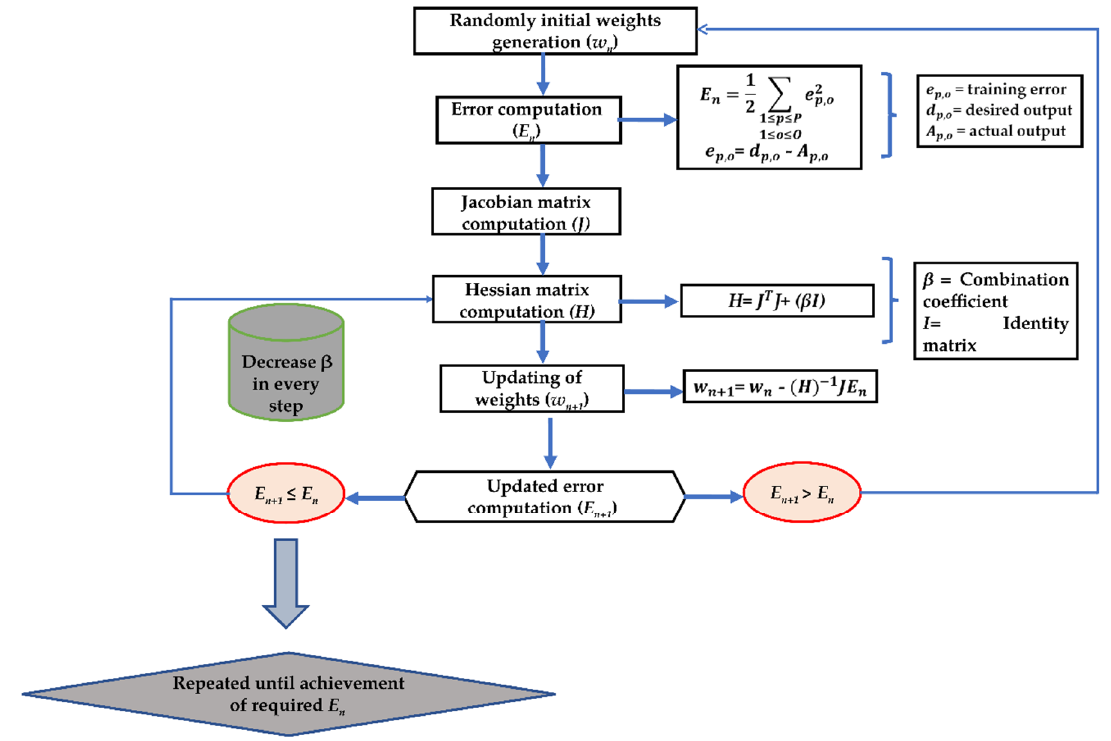
Figure 1. Flow chart for Levenberg–Marquardt Algorithm (LMA) considered in Artificial Neural Network (ANN).